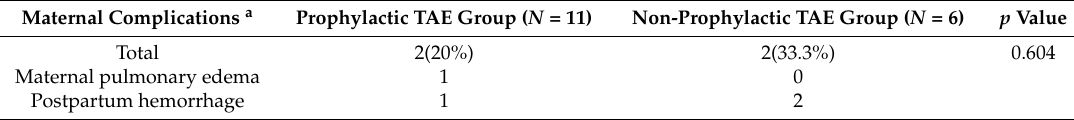
Table 3. Secondary outcome.